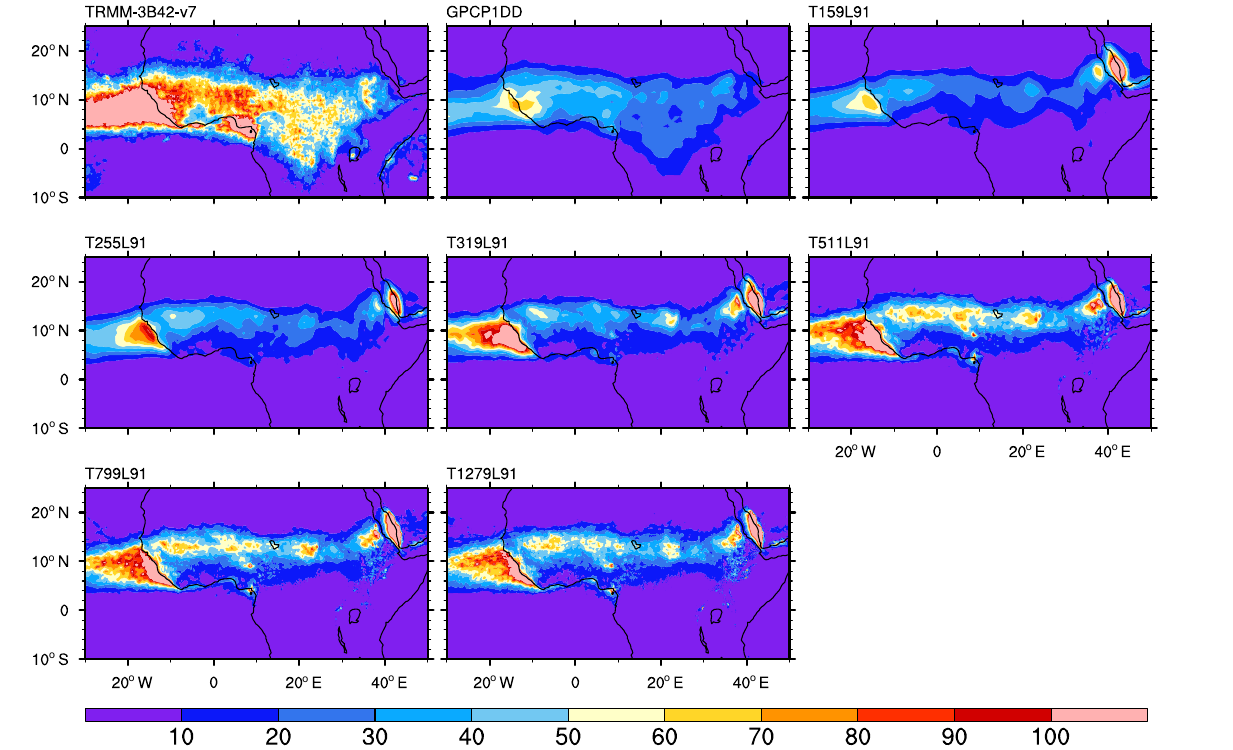
Figure 12. The 3–10-day band-pass-filtered JJAS precipitation variance for TRMM (0.25 ◦ × 0.25 ◦ ), GPCP-1DD (1 ◦ × 1 ◦ ), and T159, T255, T319, T511, T799, and T1279 EC-Earth simulations (mm 2 day − 2